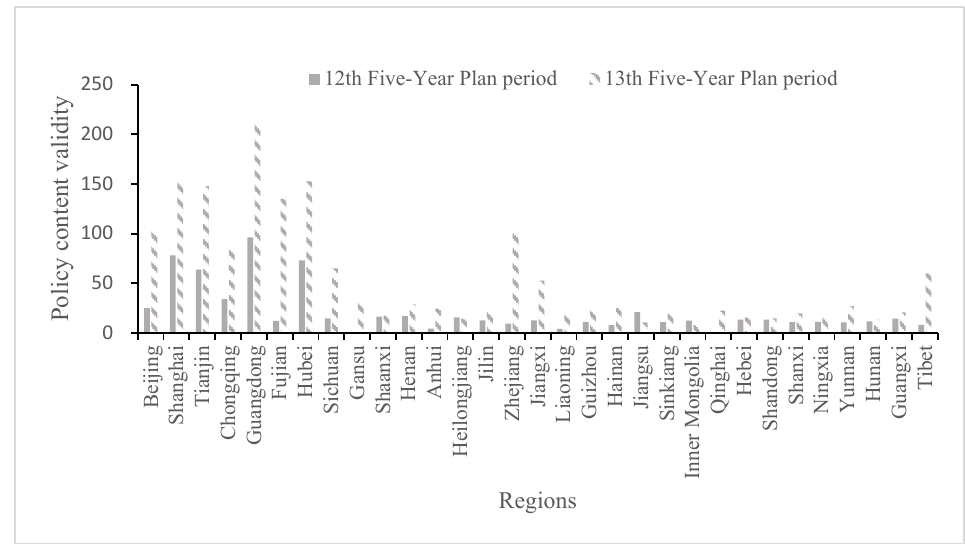
Figure 5. Mean values of the content validity of CET policies across different regions in China during the 12th (2011–2015) and 13th Five-Year Plan (2016–2020) periods. (Note: here, CET policies separately promulgated by Shenzhen were merged into Guangdong Province, and the content validity of CET policies for Guangdong Province was calculated; the data supporting the figure was calculated by the authors).